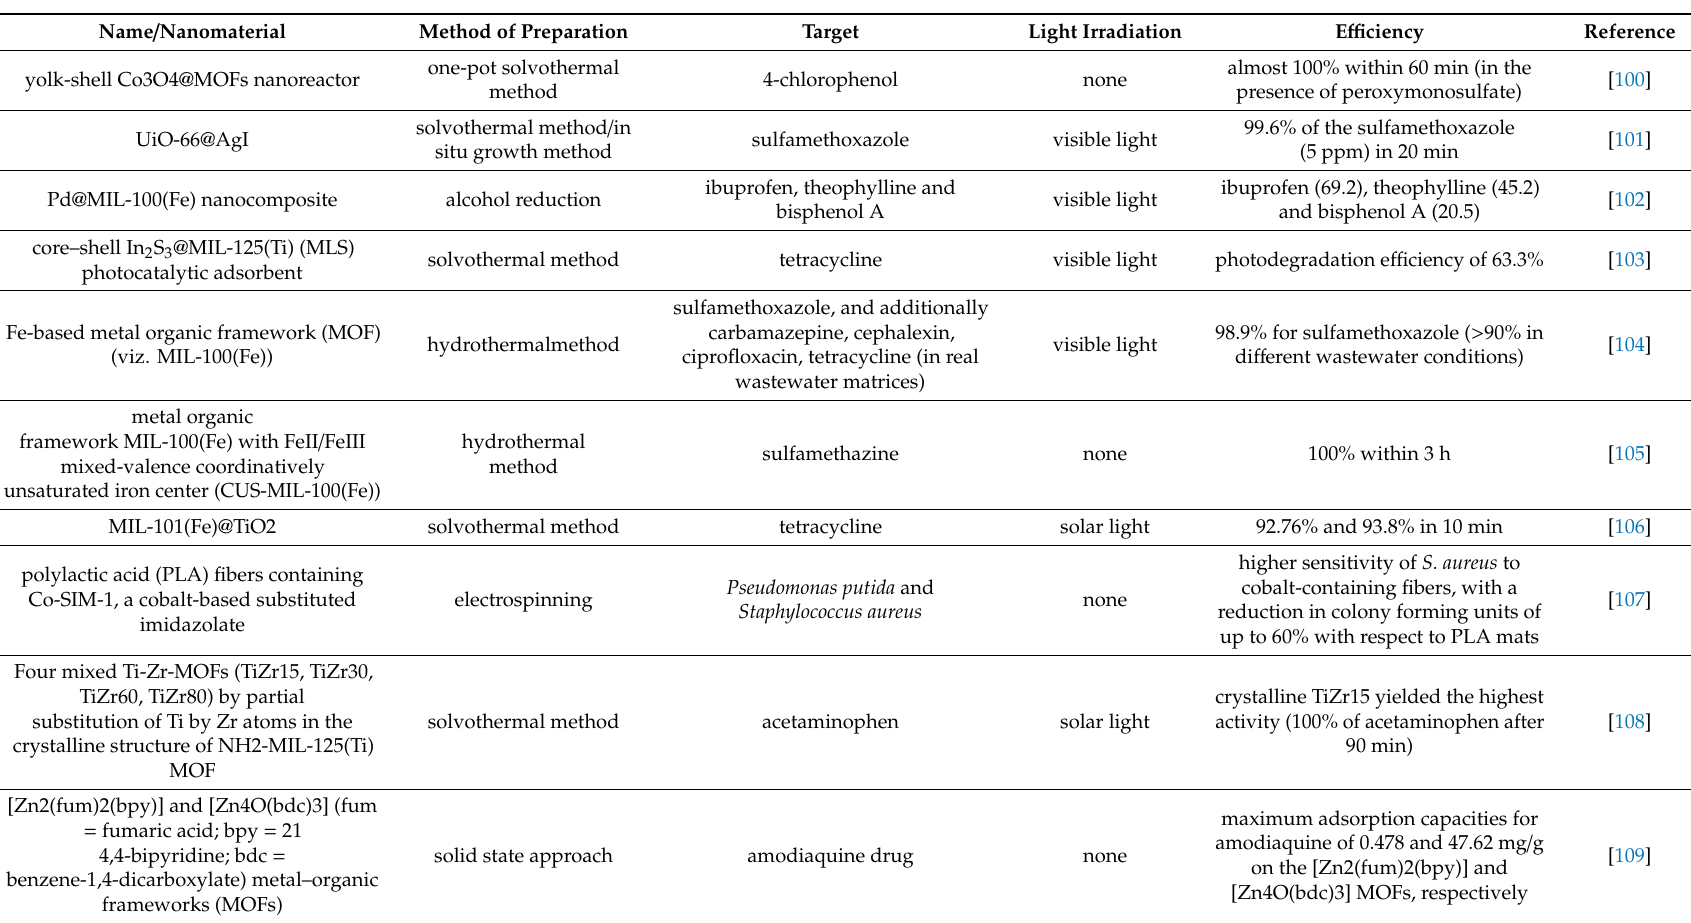
Table 3. Selected publications on metal organic frameworks (MOFs)-based nanomaterials for the treatment of emerging water micropollutants and